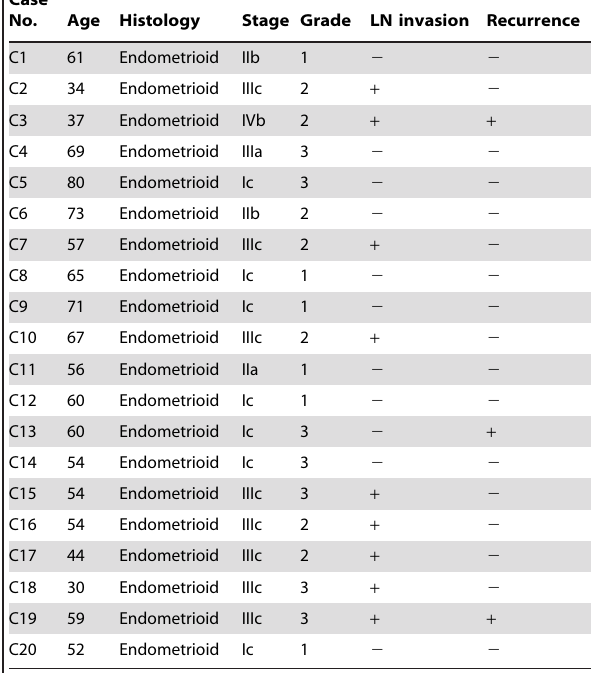
Table 2. Patient characteristics of FFPE specimens diagnosed with endometrioid adenocarcinoma used to validate the miRNA